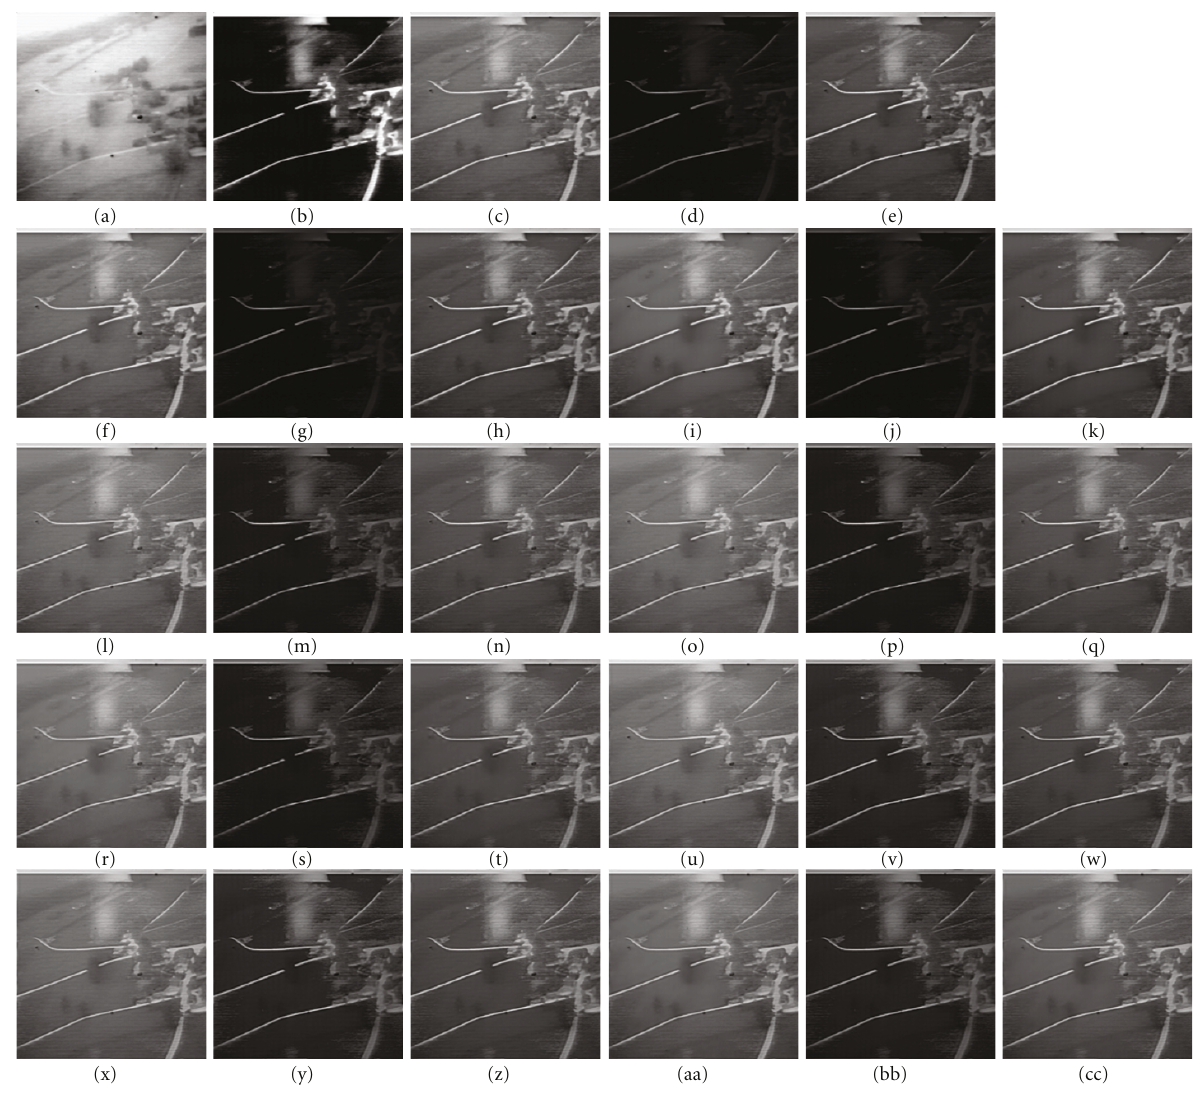
Figure 12: (a) and (b) Original “navigation” source images, image fusion results using (c) LP/AM, (d) LIP-LP/AM, (e) PL-LP/AM, (f) LP/BK, (g) LIP-LP/BK, (h) PL-LP/BK, (i) LP/RB, (j) LIP-LP/RB, (k) PL-LP/RB, (l) DWT/AM, (m) LIP-DWT/AM, (n) PL-DWT/AM, (o) DWT/BK, (p) LIP-DWT/BK, (q) PL-DWT/BK, (r) DWT/RB, (s) LIP-DWT/RB, (t) PL-DWT/RB, (u) SWT/AM, (v) LIP-SWT/AM, (w) PL-SWT/AM, (x) SWT/BK, (y) LIP-SWT/BK, (z) PL-SWT /BK, (aa) SWT/RB, (bb) LIP-SWT/RB, (cc)